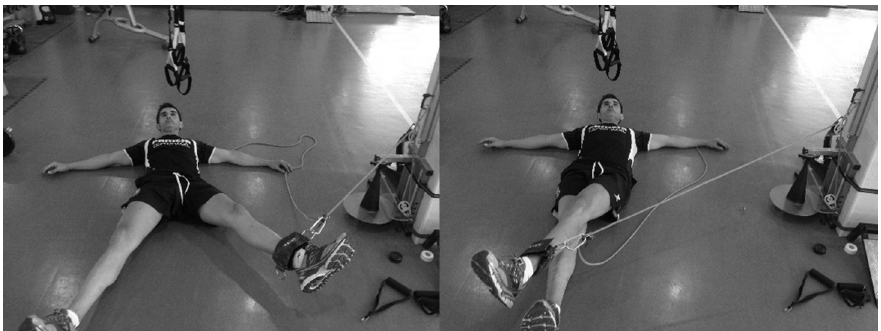
Figure 1. Rotary inertial device adductor exercise.